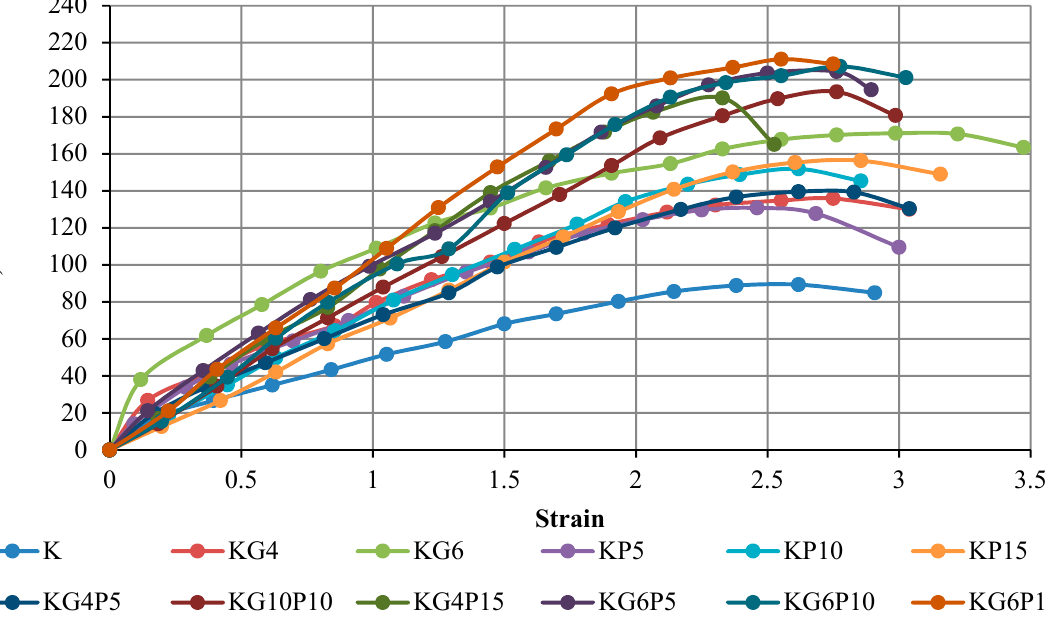
Figure 7. Stress–strain curve of kaolin and treated kaolin with gypsum and POFA tested after 7 days of curing.